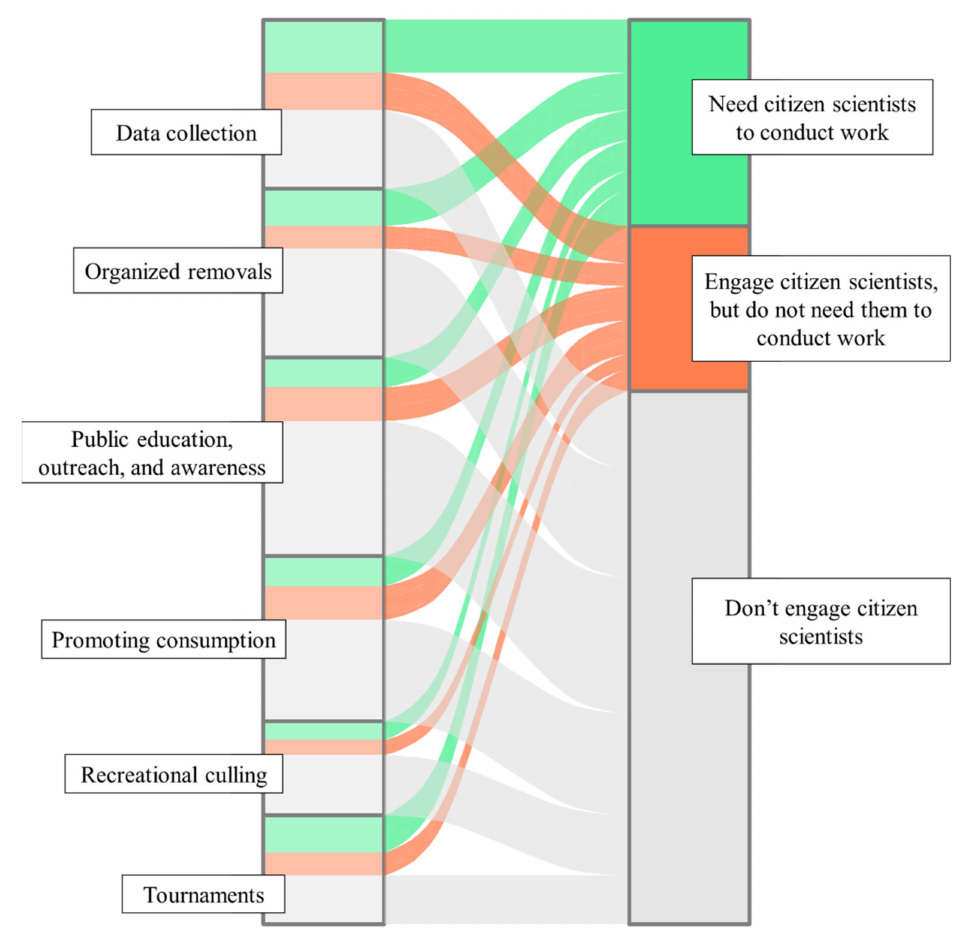
Figure 4. Alluvial plot demonstrating the perceived impact score of the six top-ranked directly im- plemented approaches for lionfish management and their proportionate connection to organizations’ engagement of citizen scientists and whether the organization needs citizen scientists to carry out their